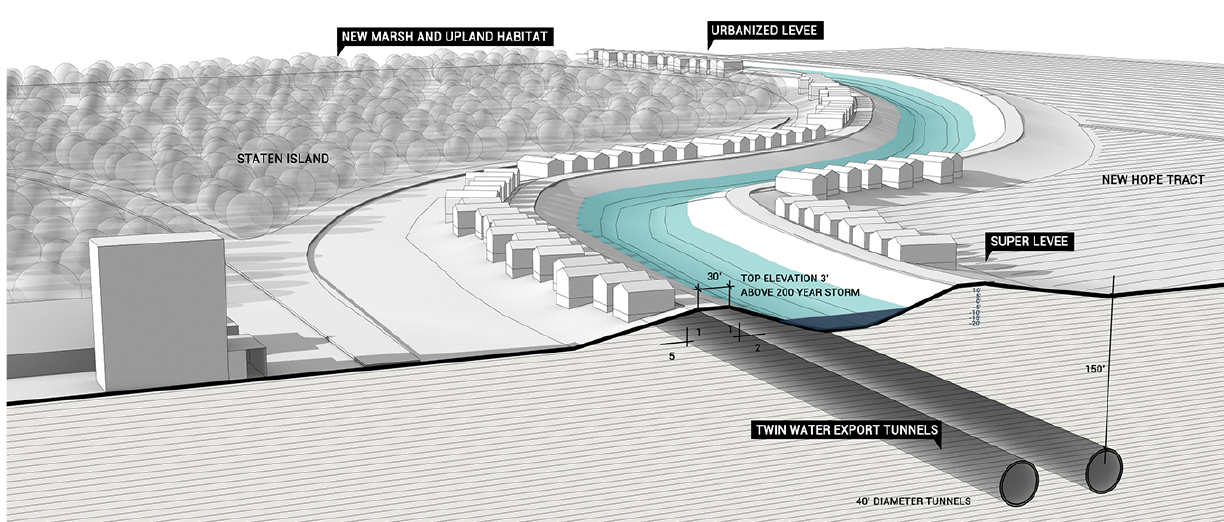
Figure 11. Spatially modeled section of the Water Machine scenario (WaterFix), showing urbanized super levees along the in-Delta water conveyance channels, restoration areas, and the subterranean tunnel infrastructure (from Milligan & Holmes,